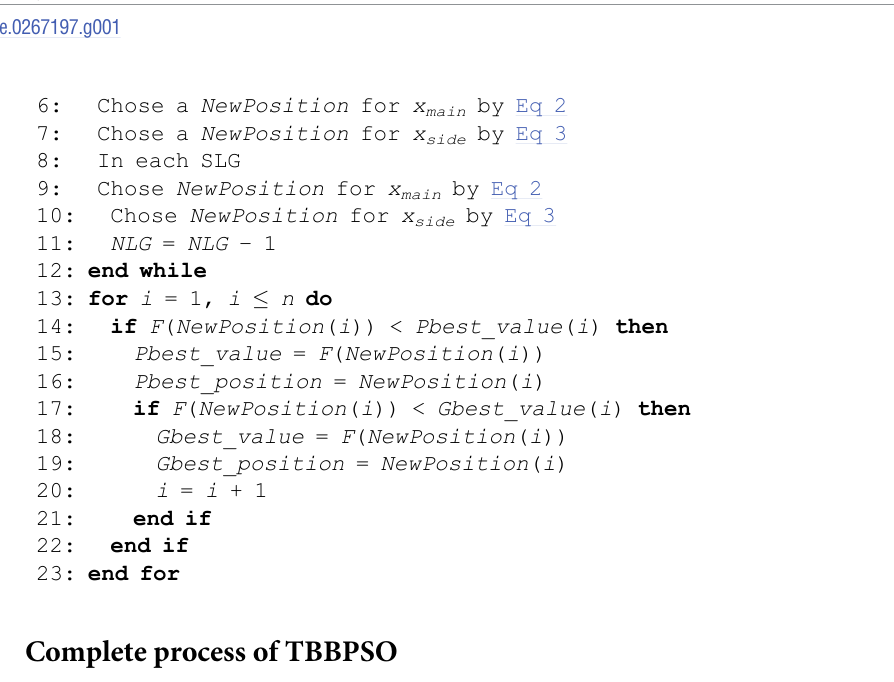
Fig 1. Schematic diagram of TBBPSO. Phase 1: All particles are in a same group, TGO is used to generate twins; in each twin, one particle is the group leader and the other one is the teammate; one twin will be selected as the MLG; go to Phase2. Phase 2: In each iteration, the MLG will merge one twin using MO. When all twins are in the MLG, go to Phase